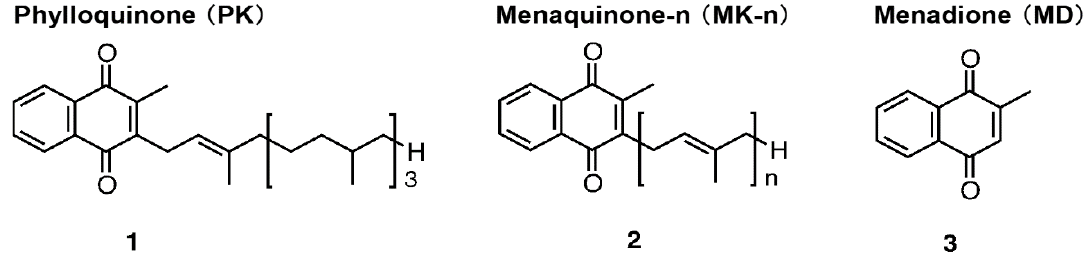
Figure 1. Chemical structure of vitamin K.